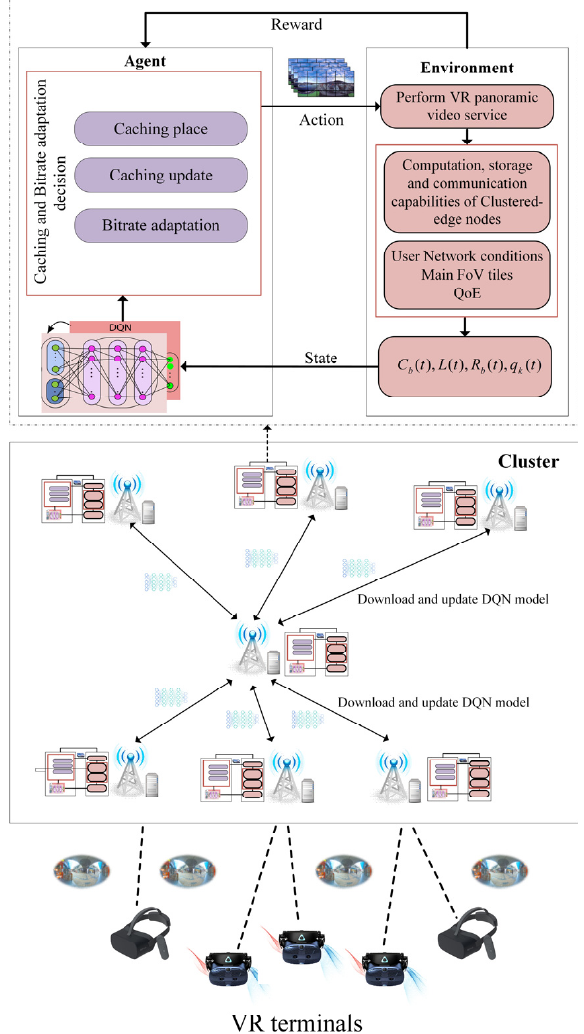
Figure 3. The VR panoramic video service scheme based on FDRL-CBA within an edge cluster.